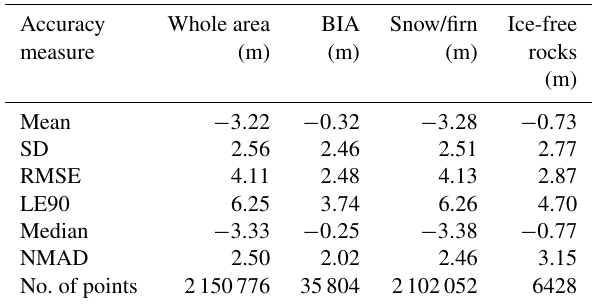
Table 1. Accuracy numbers for height differences of TanDEM-X minus ICESat for the whole of Antarctica and individual classes of blue ice areas, snow/firn, and ice-free rocks according to Antarcti- caLC2000.